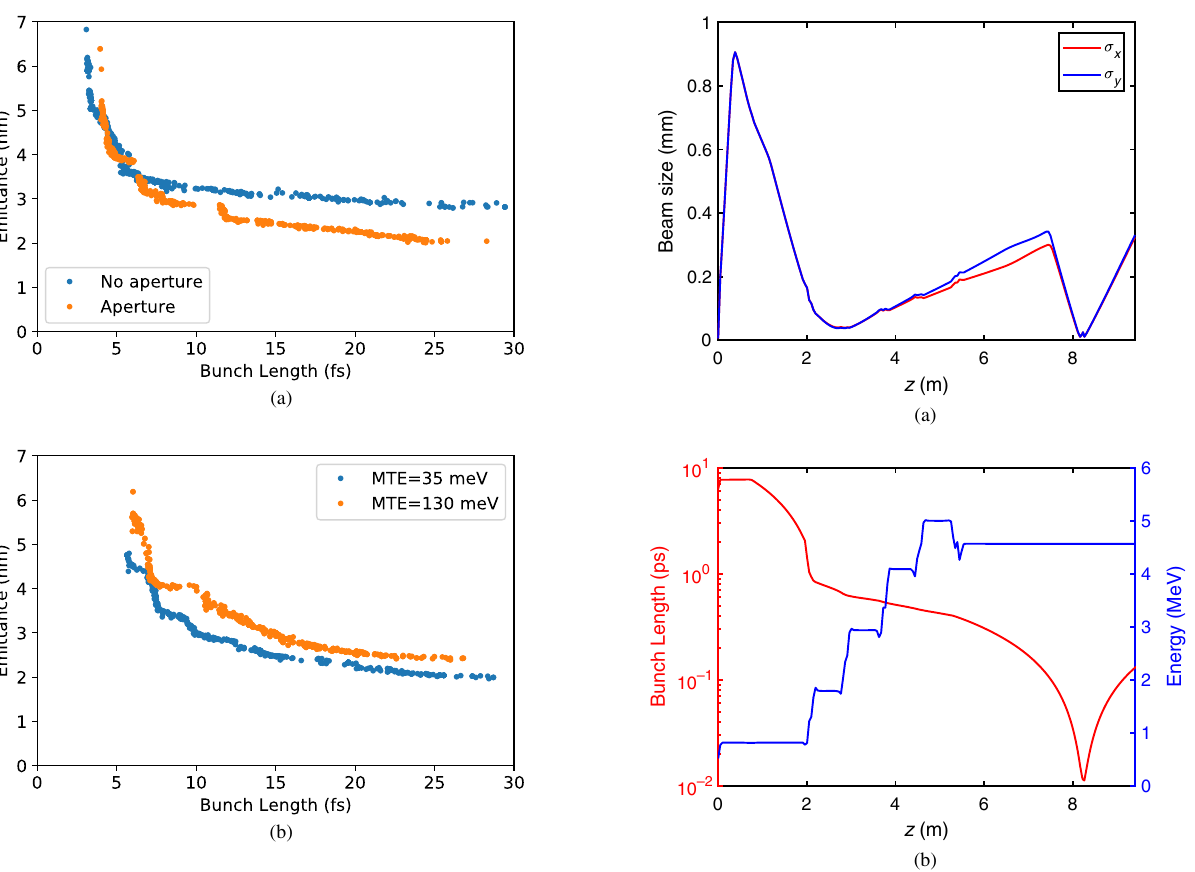
FIG. 6. (a) Influence of collimation on the achievable bunch length and emittance with a final bunch charge of 16 fC. (b) Effects of the cathode mean transverse energy (MTE) on the final bunch length and emittance at the same charge.